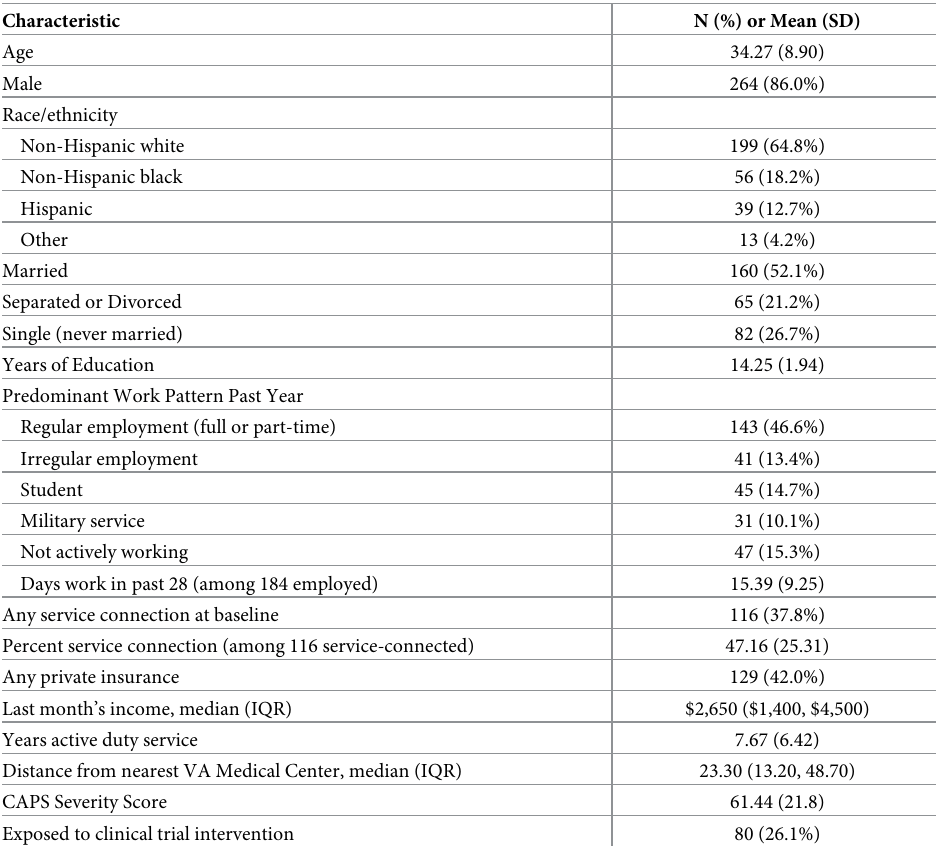
Table 1. Sample description (n =